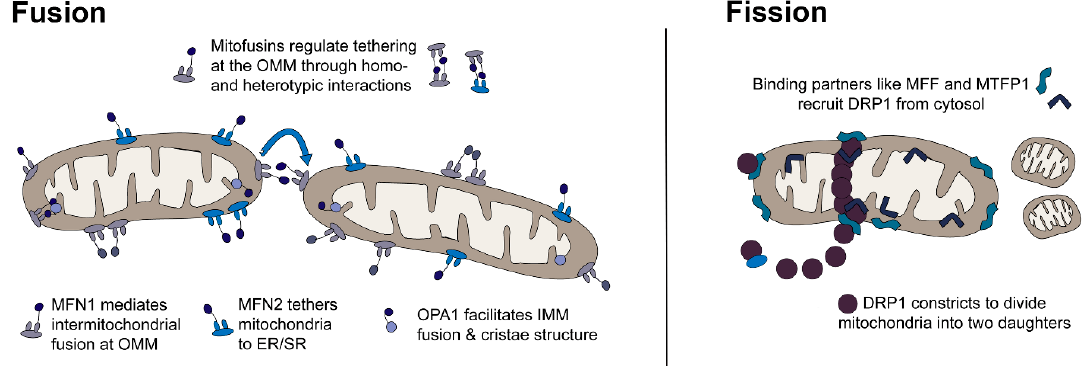
Figure 1. Mitochondria are highly dynamic, which allows adaptive energy production under changing metabolic conditions (starvation, feeding, exercise, rest, high and low oxygen supply). Mitochondria sense metabolic signals to trigger fusion (joining) and fission (division) which allows a change in their number, shape, and function through replication, culling, and recycling of mtDNA. Fusion ( left ) is regulated by homotypic and heterotypic interactions between dynamin related GTPases including mitofusin (MFN) 1 and 2 at the outer mitochondrial membrane (OMM) and optic atrophy (OPA1) at the inner mitochondrial membrane (IMM). Fission ( right ) is mediated by recruitment of dynamin related protein (DRP1) from the cytosol to binding proteins including OMM, mitochondrial fission factor (MFF), and IMM mitochondrial fission process 1 (MTFP1).